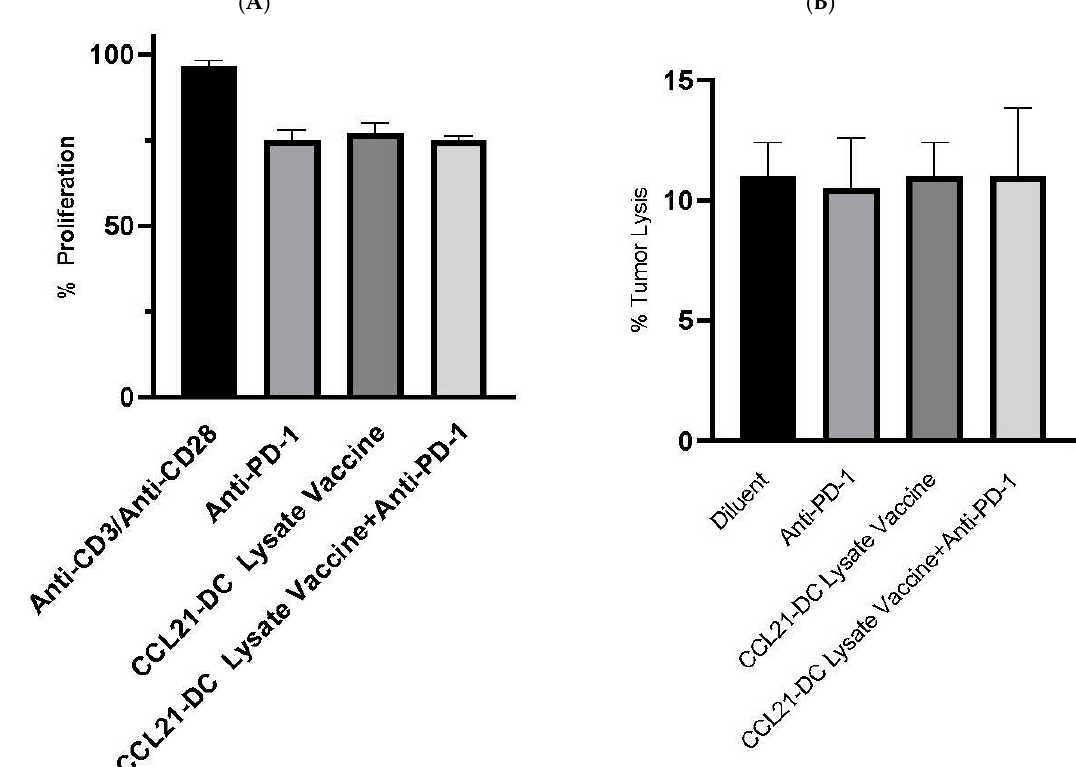
Figure 5. ( A , B ) Tregs and NK cells from CCL21-DC lysate vaccine plus anti-PD-1 did not have a change in activity. Purified Tregs (1:5) from combined therapy did not alter the proliferation of anti-CD3/anti-CD28 (0.2/2 µg/mL) stimulated T cell proliferation. Almar blue (20 µL) was added for 4 h on day 3, and fluorescence was read at excitation/emission (530nm/595nm) in a Wallac Fluorescence reader.